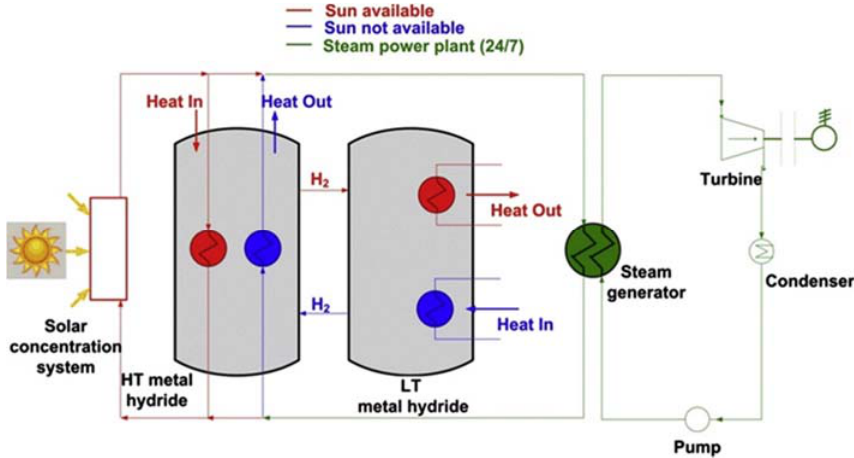
Figure 1. Schematic diagram of solar thermal energy storage system based on the metal hydrides. Reproduced with the permission from [4], Copyright Elsevier, 2015.